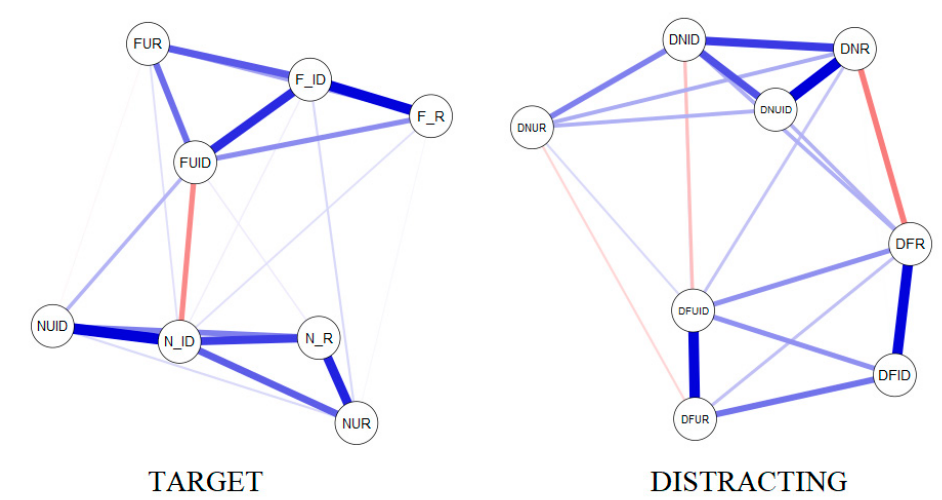
Figure 4. Centrality Plot. Target stimuli (left side): NUR = Unrelated Masked Priming Word–Face; NUID = Unrelated Masked Priming Word–Word; N_R = Related Masked Priming Word–Face; N_ID = Identity Masked Priming Word–Word; FUR = Unrelated Masked Priming Word–Face; FUID = Unrelated Masked Priming Face–Face; F_R = Related Masked Priming Word–Face; F_ID = Identity Masked Priming Face–Face. Distracting stimuli (right side): DNUR = Unrelated Masked Priming Word–Face; DNUID = Unrelated Masked Priming Word–Word; DN_R = Related Masked Priming Word–Face; DN_ID = Identity Masked Priming Word–Word; DFUR = Unrelated Masked Priming Word–Face; DFUID = Unrelated Masked Priming Face–Face; DF_R = Related Masked Priming Word– Face; DF_ID = Identity Masked Priming Face–Face.